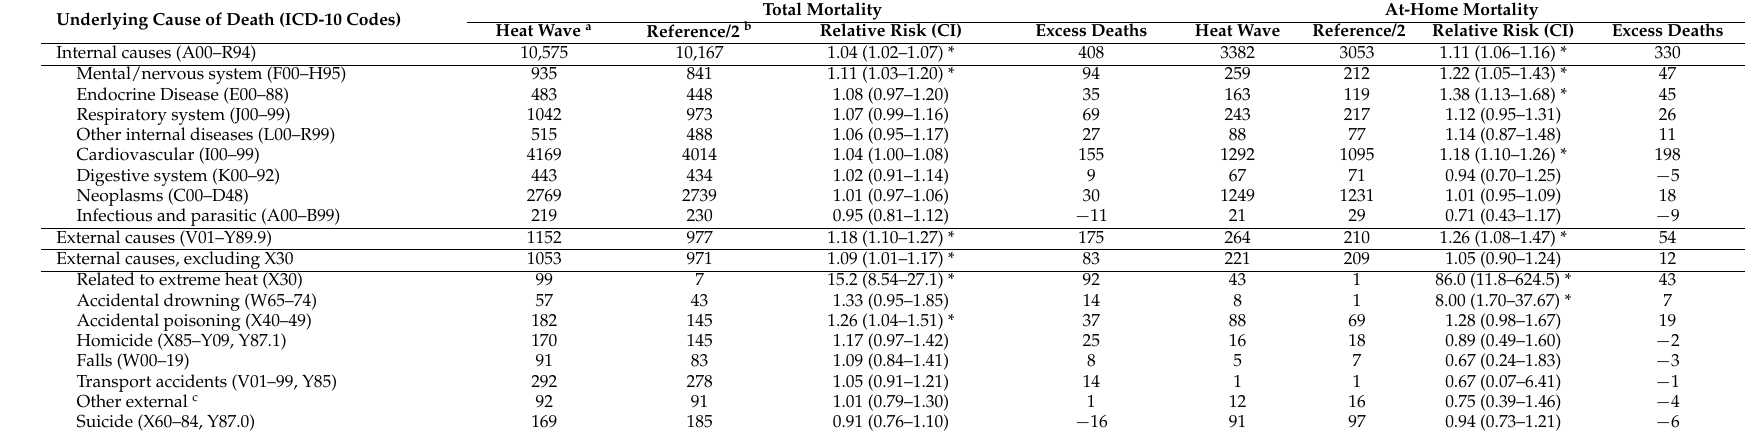
Table 2. Heat wave mortality relative risk and excess deaths for all deaths and deaths that occurred at-home, by underlying cause of death. Underlying Cause of Death (ICD-10